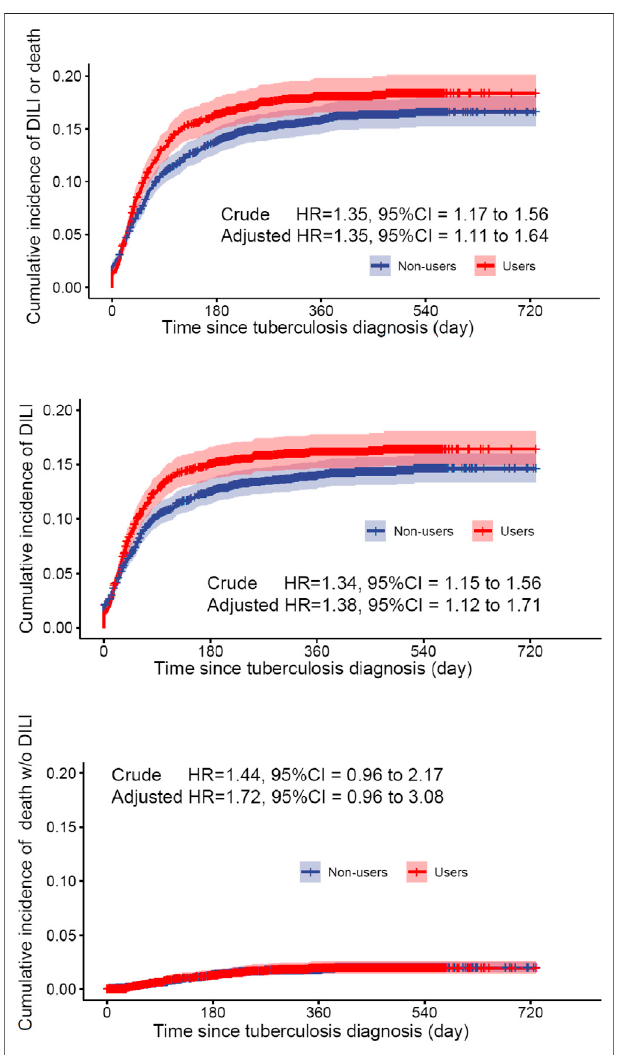
FIGURE 1 | Survival probability for DILI or all-cause mortality in the hepatoprotective agent user group and the control group in the weighted cohort.